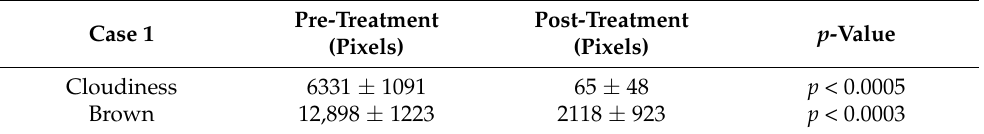
Figure 4. Case 1: Intraoral photograph before treatment. Table 1. In Case 1, the cloudiness and brown areas from the pre-treatment (before applications) and post-treatment (after 7 applications) images were measured as pixels by digital image analysis. The analysis was performed three times and the mean measures and standard deviations were calculated (mean ± SD). The significance of the differences in areas before and after treatment was evaluated with p -values by t